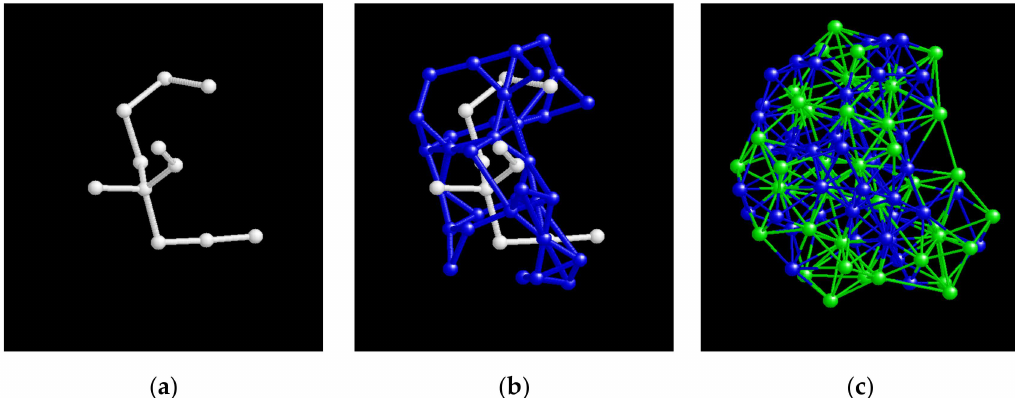
Figure 17. Snapshots of a 6-ring bond sharing network formed by eleven connecting Z-clusters found in a glassy phase of the r BB = 0.8 A 35 B 65 system: ( a ) Z-cluster network linked by 6-ring bonds, ( b ) I-cluster network (blue) linked by 5-ring bonds included as nearest neighbors to the eleven Z-clusters, and ( c ) all atoms belonging the Z-clusters’ network, where green and blue spheres denote the A and B atoms, respectively.